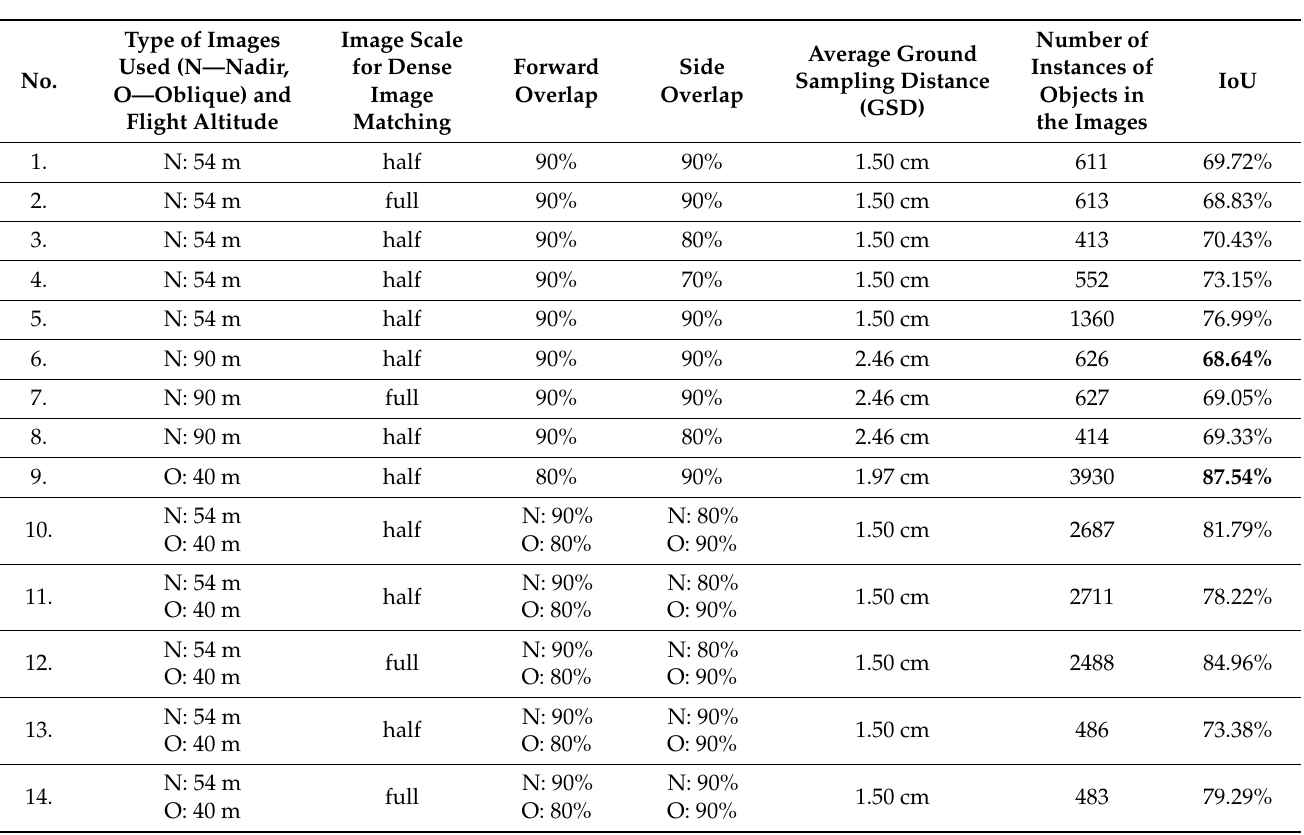
Table 8. Accuracies of the resulting bounding boxes for the traction poles for fourteen point cloud variants. The table values are the average IoU (Intersection over Union) multiplied by 100%, which is the evaluation